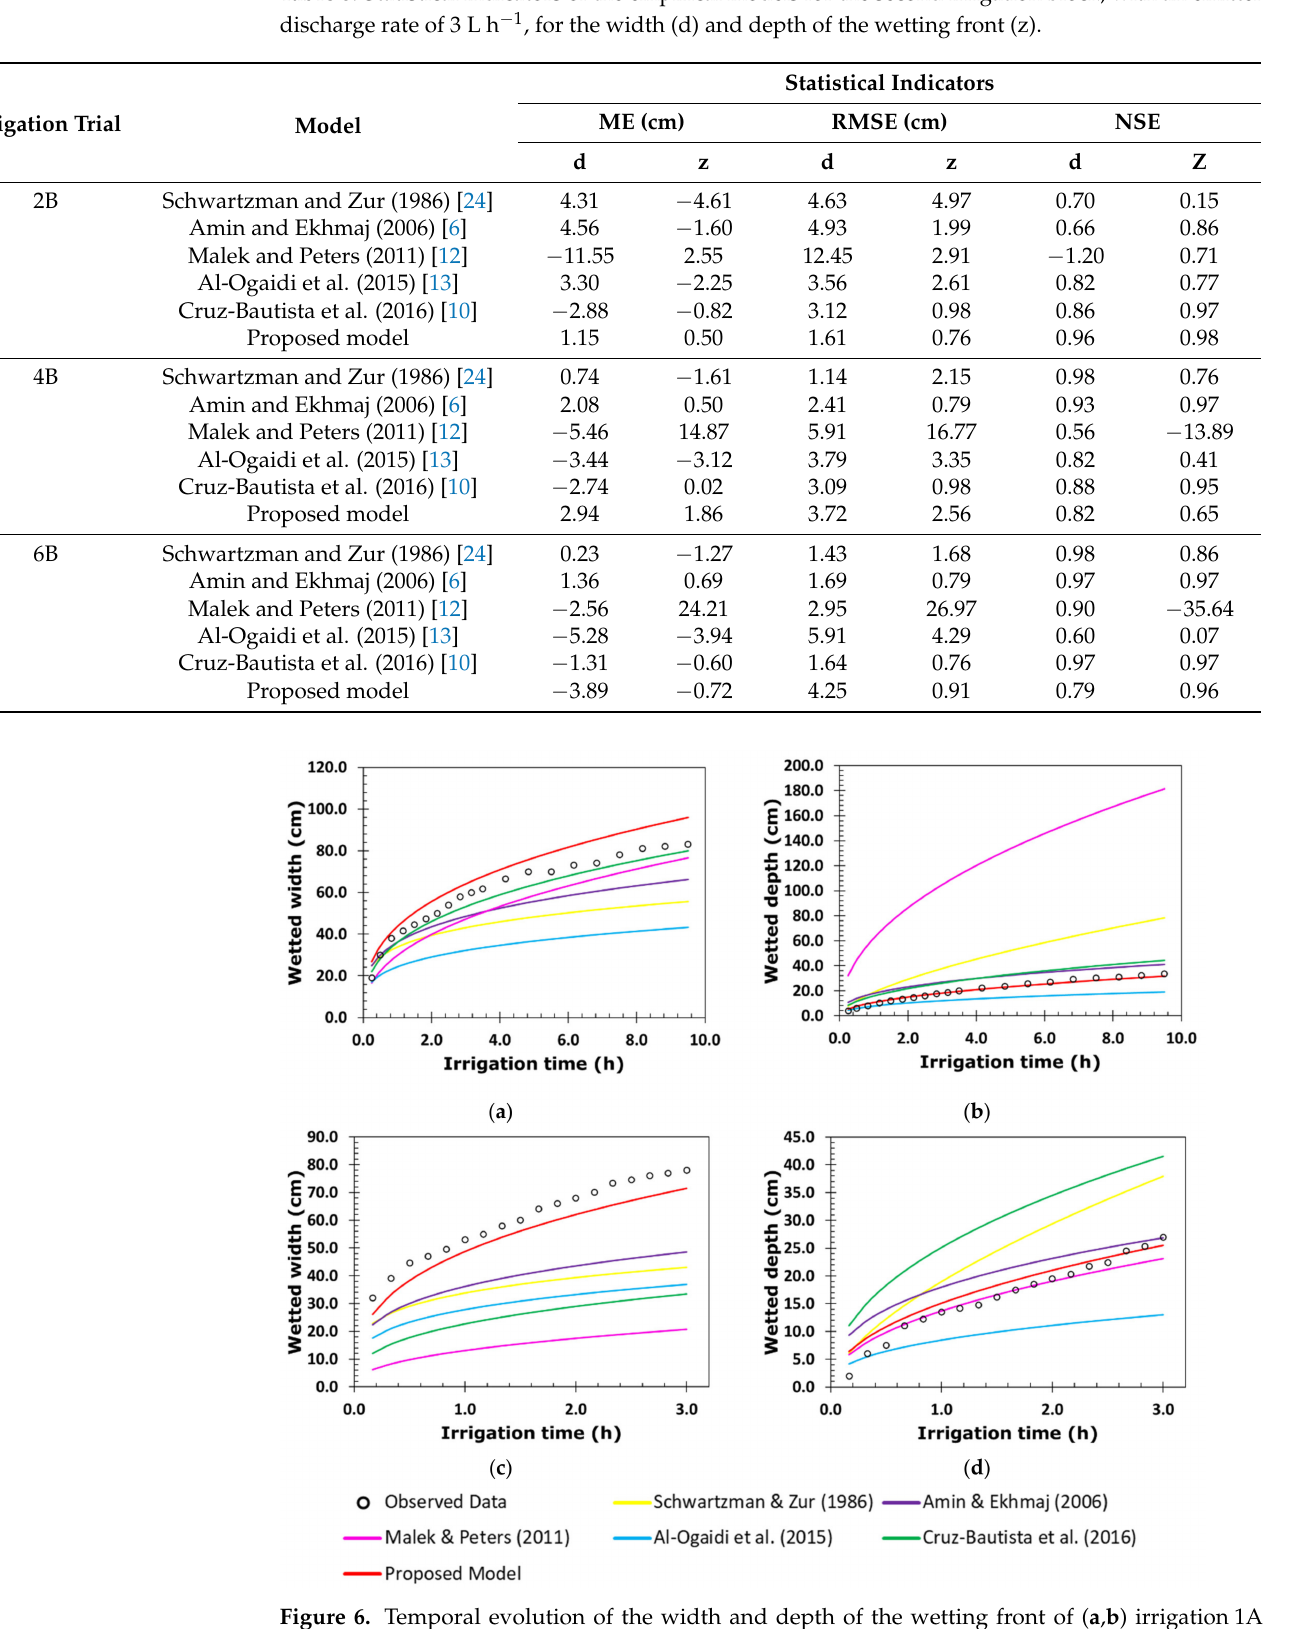
Figure 6. Temporal evolution of the width and depth of the wetting front of ( a , b ) irrigation 1A (q = 2.90 L h − 1 and θ i = 0.07 cm 3 cm − 3 ) and ( c , d ) irrigation 2A (q = 2.90 L h − 1 and 3 cm − 3 ) θ i = 0.23 cm